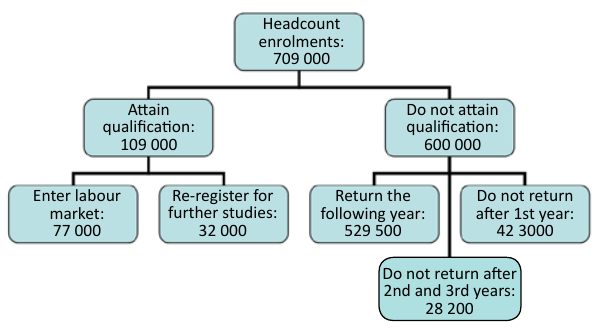
FIGURE 3: Annual outflows from public higher education institutions during the 2002–2004